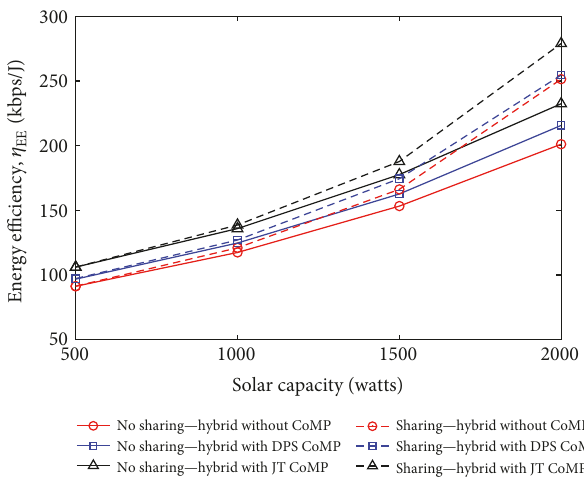
Figure 15: EE for di ff erent hybrid schemes with energy sharing under varying solar